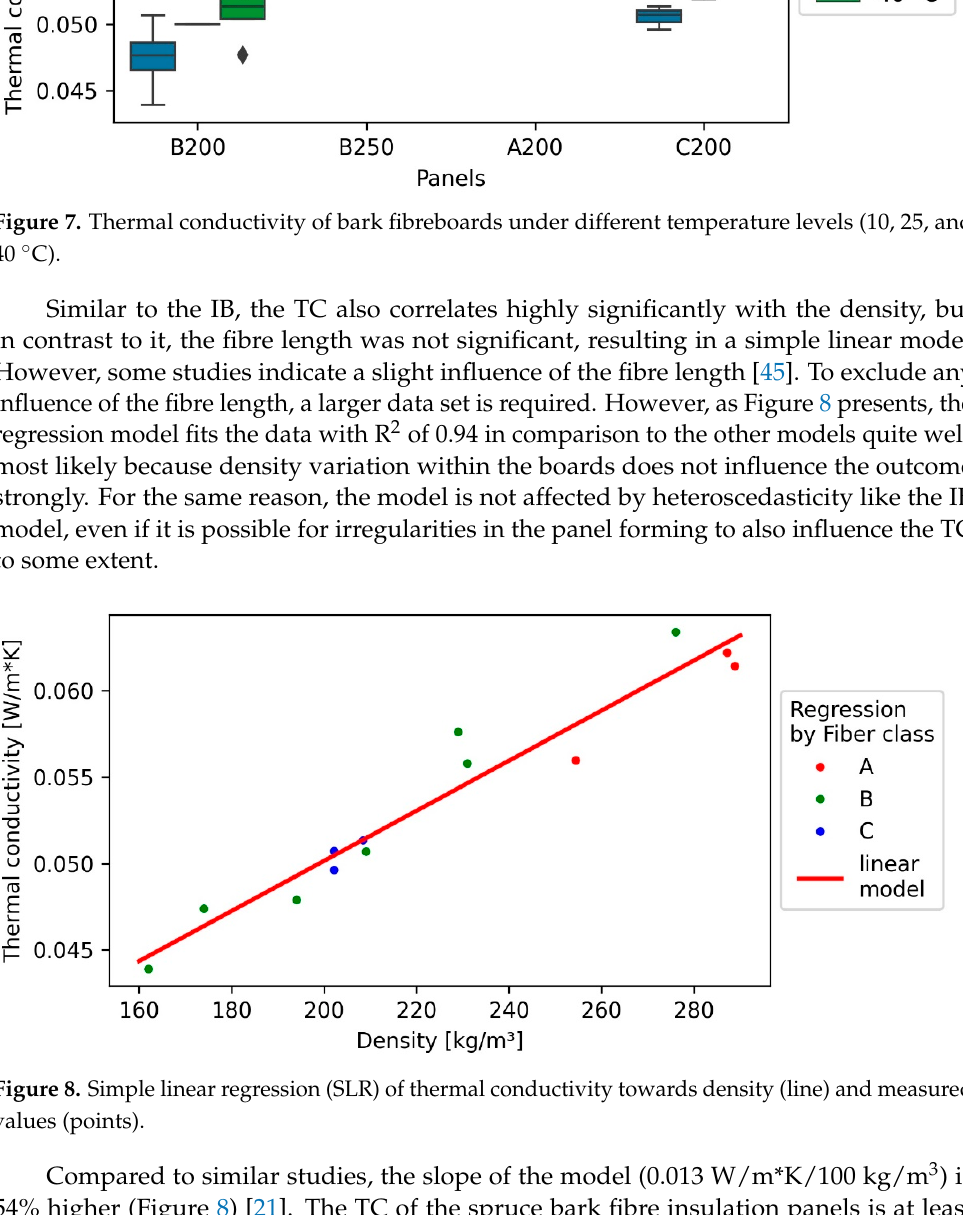
Figure 8. Simple linear regression (SLR) of thermal conductivity towards density (line) and meas- ured values (points).